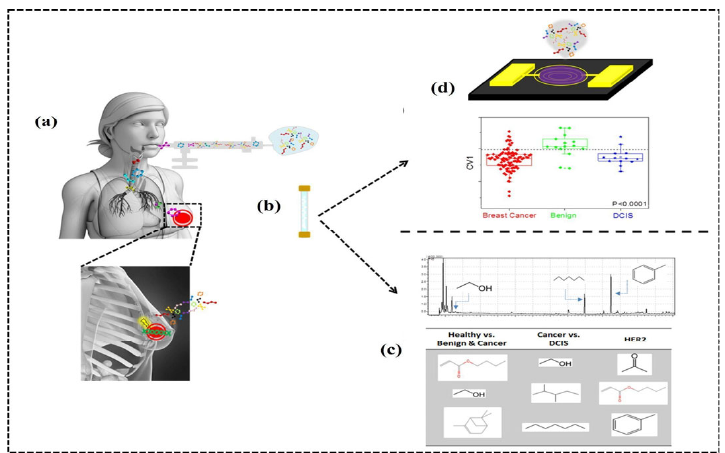
Figure 8. ( a ) Exhalation and sample collection, ( b ) concentrated on Tenax ® TA sorption tubes, ( c ) GC ‐ MS analysis of the collected sample, ( d ) exposed to nanosensor array [119]. Table 5. Various biomarkers and their relevant functional group specific towards breast cancer.